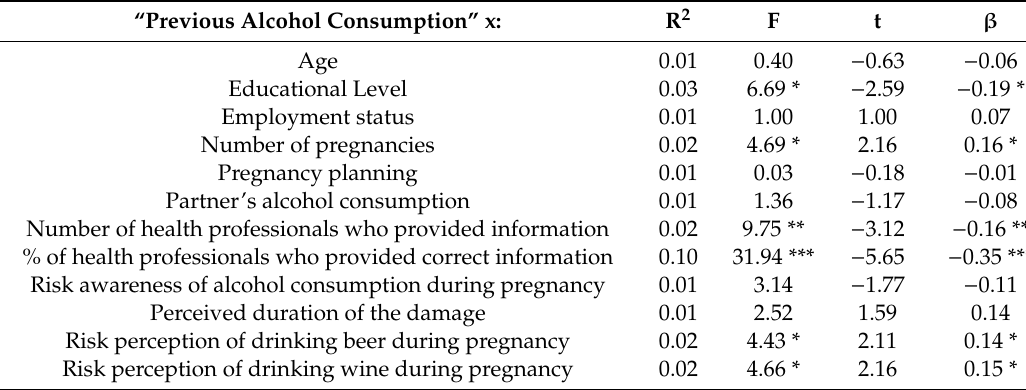
Table 3. Regression analyses of the moderations by demographics, obstetric history, the partner’s alcohol consumption, advice received from health professionals, and beliefs about risks, in the relationships between previous and current alcohol